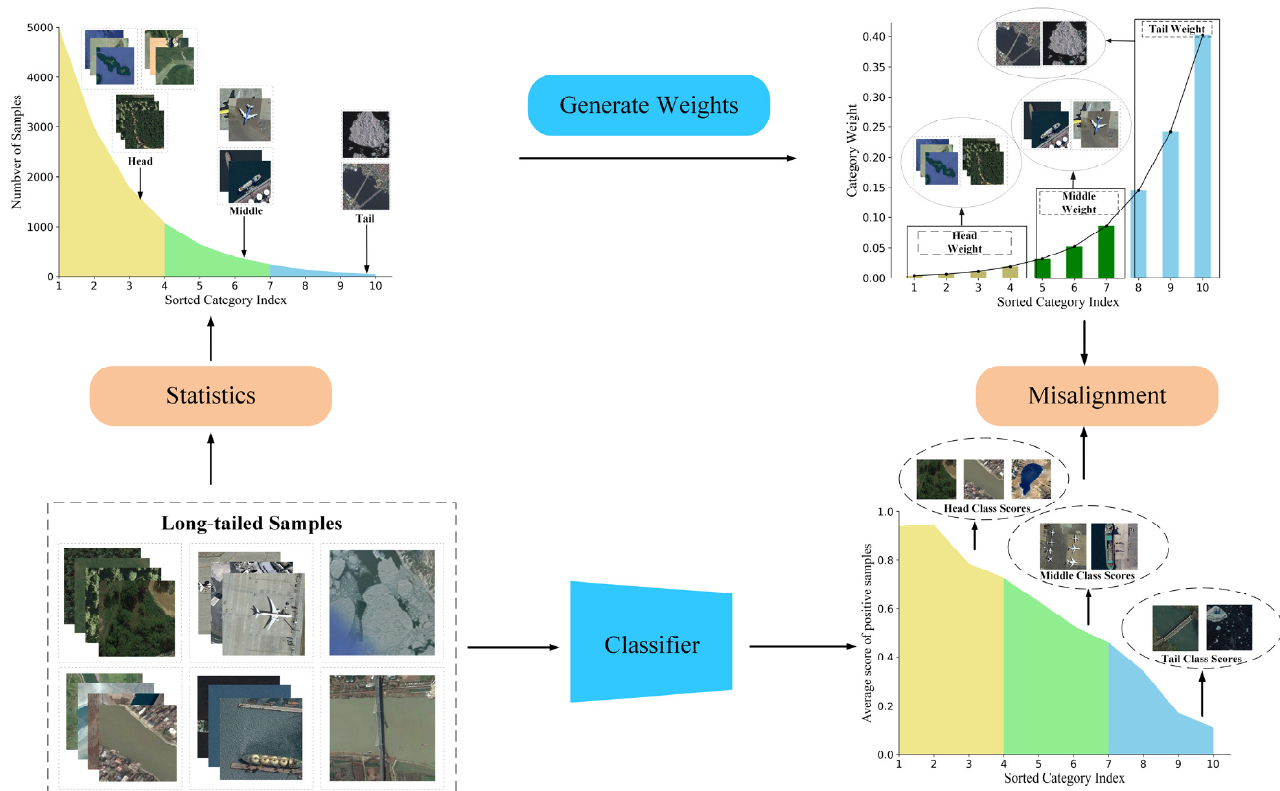
Figure 2. The loss reweighting method based on the number of samples from each category does not consider the difference in classification difficulty of samples from various categories and cannot adapt to the relatively dynamic training process of the model, which can easily cause the misalignment between the category weights and the real learning state of the model.